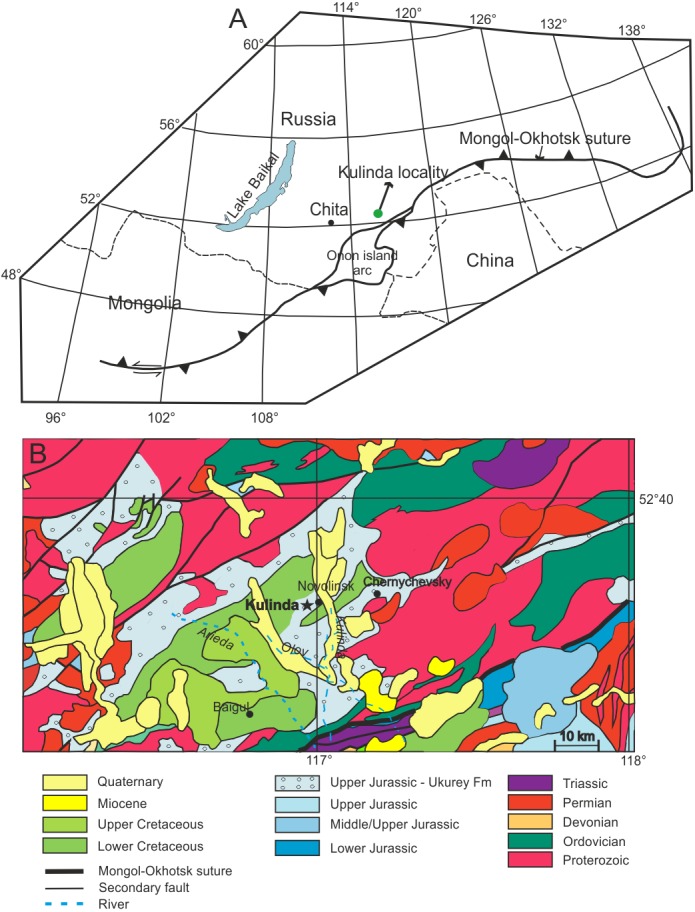
Location of the studied area.(A) Position of Kulinda locality with respect to the Mongol-Okhotsk suture (modified with permission from Tomurtogoo et al., 2005). (B) Geological map of the Kulinda region (redrawn with permission from Kozlov, Zaikov & Karasev, 1998). According to the map, Kulinda is situated in the Upper Jurassic of the Ukurey Formation.